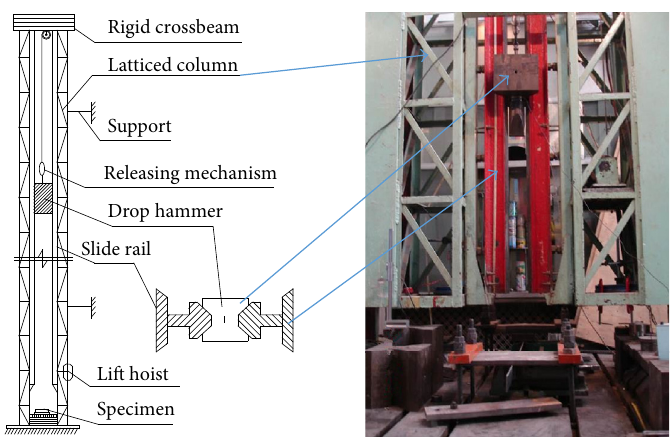
Figure 2: DHR9401 drop hammer test machine.